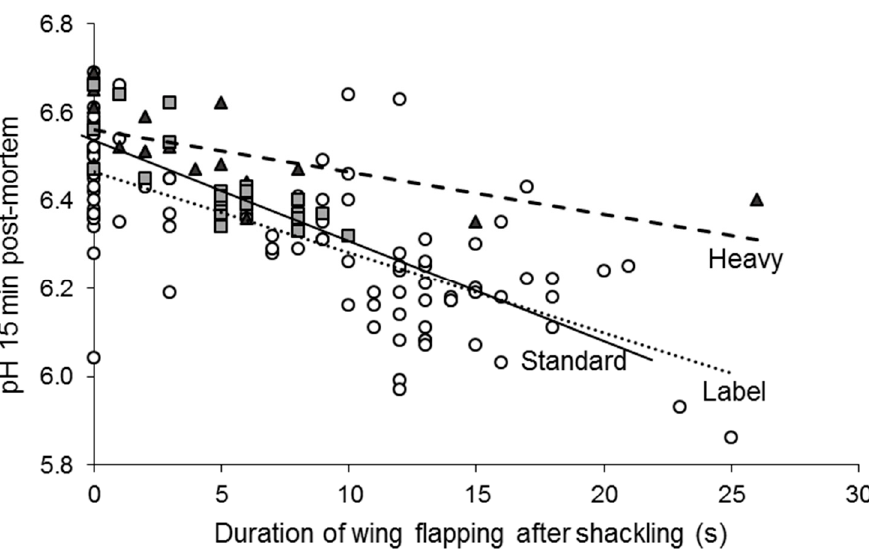
Figure 3. Duration of wing flapping significantly hastens the rate of early postmortem pH decline of fillets. Squares, circles, and triangles indicate broilers of a Standard ( r = 0.80; p < 0.001), Label ( r = 0.71; p < 0.001) and Heavy line ( r = 0.66; p < 0.001), respectively. Slopes do not differ significantly (ANCOVA on pH 15 min postmortem; interaction line x duration of wing flapping: p = 0.51). Data from [71] .